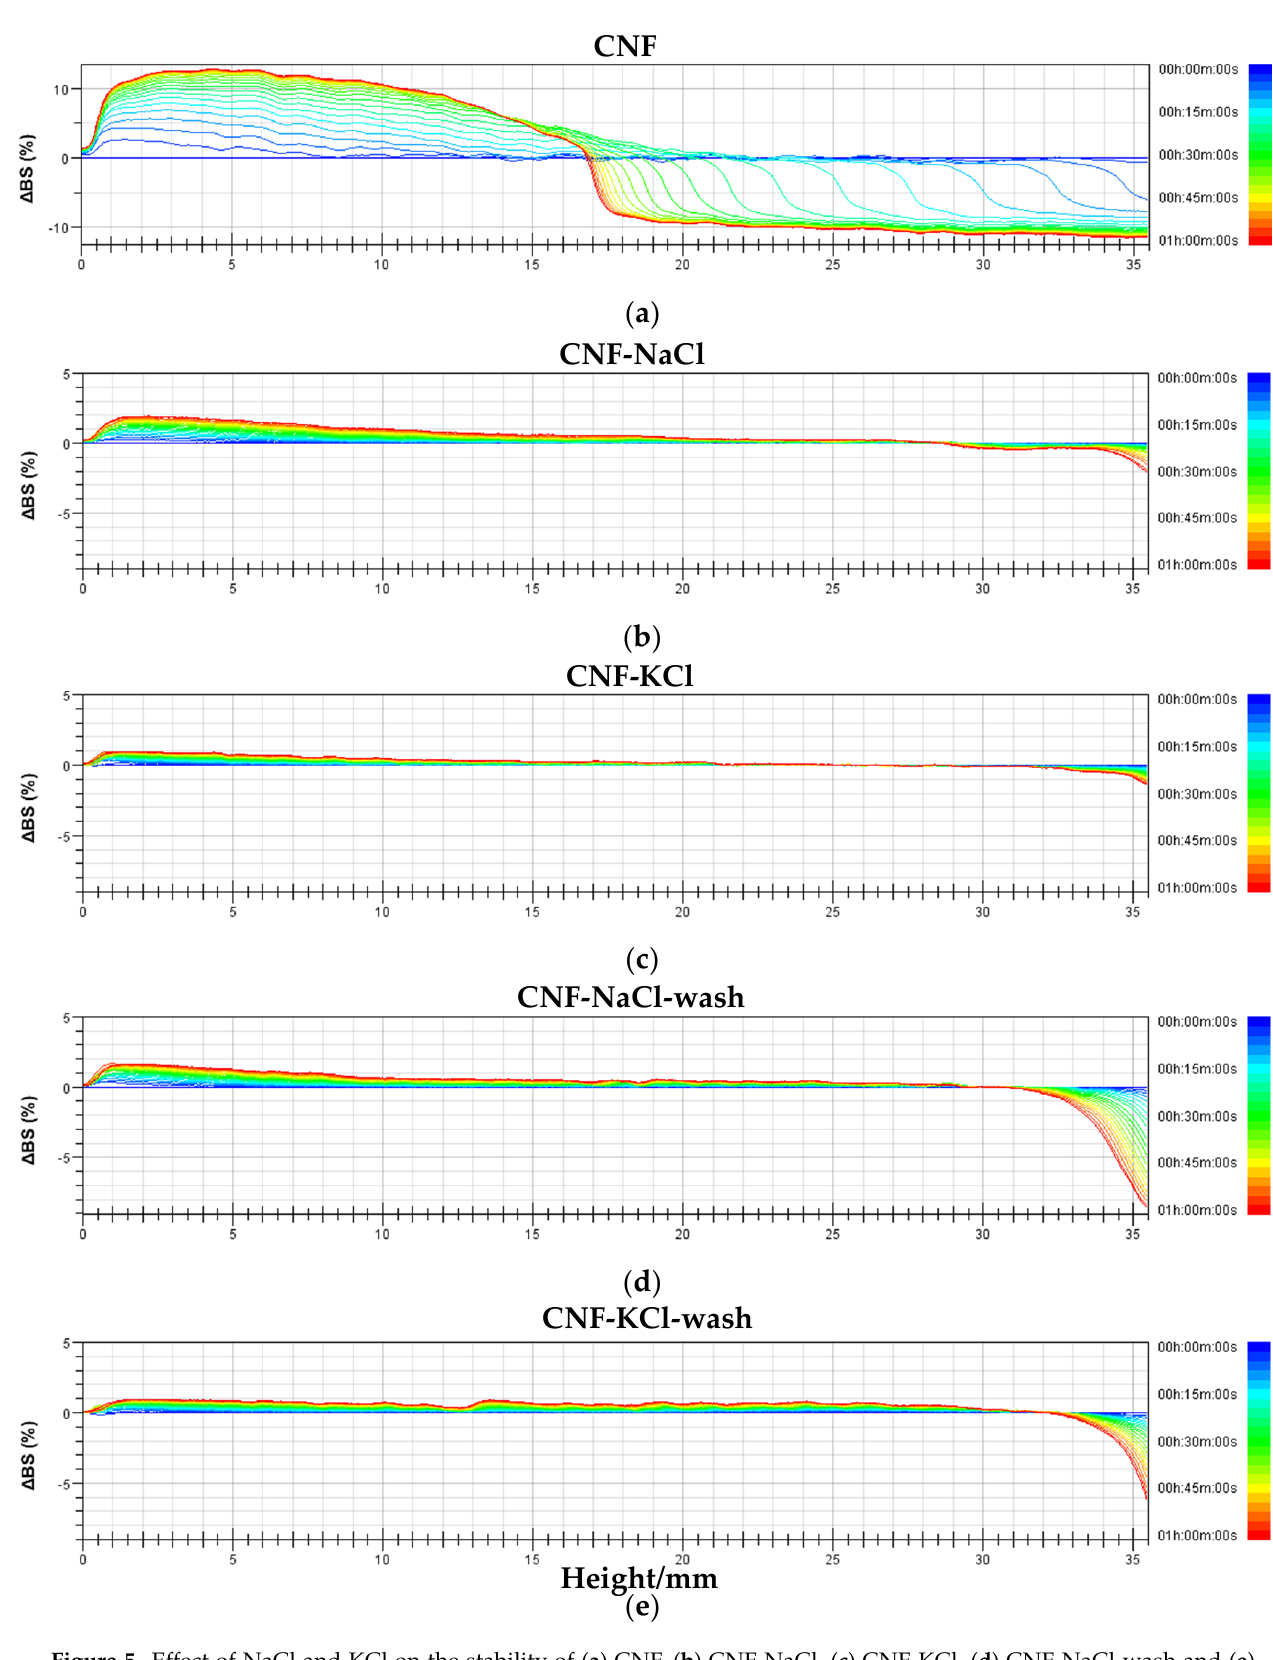
Figure 5. Effect of NaCl and KCl on the stability of ( a ) CNF, ( b ) CNF-NaCl, ( c ) CNF-KCl, ( d ) CNF-NaCl-wash and ( e ) CNF-KCl-wash (1 wt%) (measured by Turbiscan LAB Stability Analysis Tester within 60 min, the lines of different colors represent the changes in the light. .